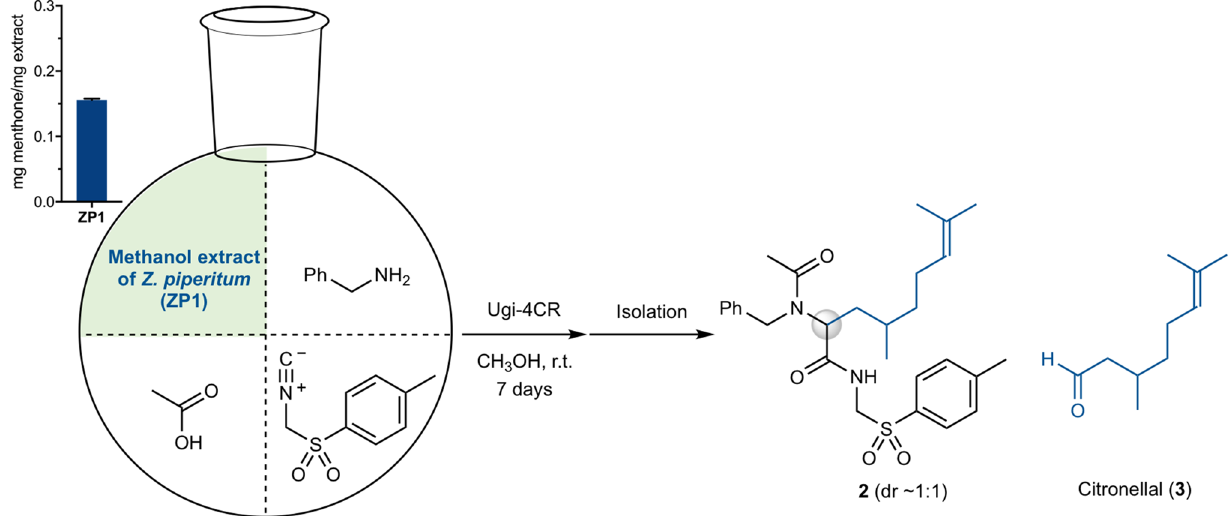
Figure 2. Synthesis of 2 by the Ugi-4CR of the methanol extract of Z. piperitum (ZP1) in the presence of benzylamine, acetic acid, and TosMIC. The inset shows the carbonyl content of the ZP1